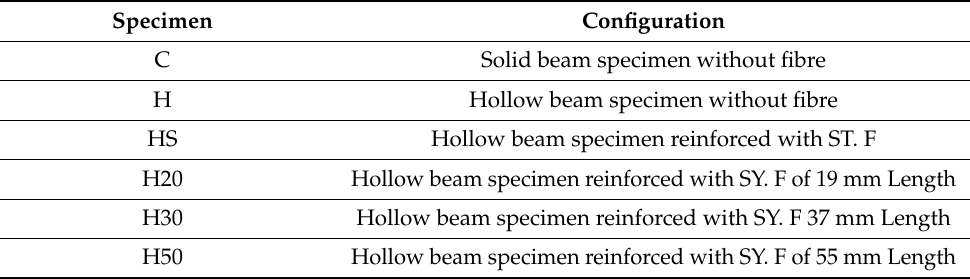
Table 9. Sample IDs [59].